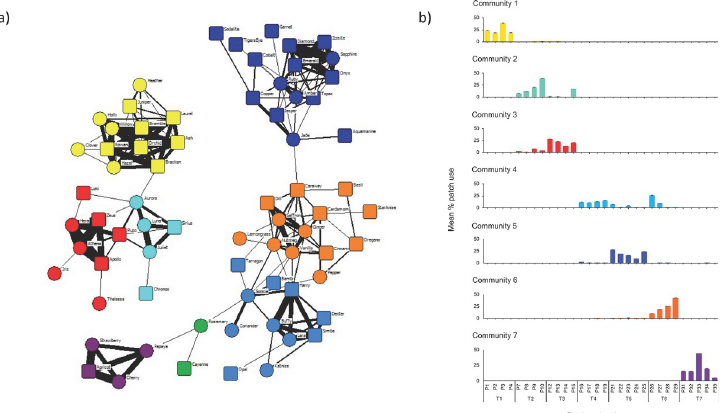
Fig 2. (a) Communities 1–8 in the fox social network, excluding isolates. Node shapes represent males ( ■ ) and females ( ● ). Line thickness is proportional to the simple ratio index (SRI). (b) Spatial profiles of communities 1–7. Colours correspond to communities in (a) and error bars indicate standard